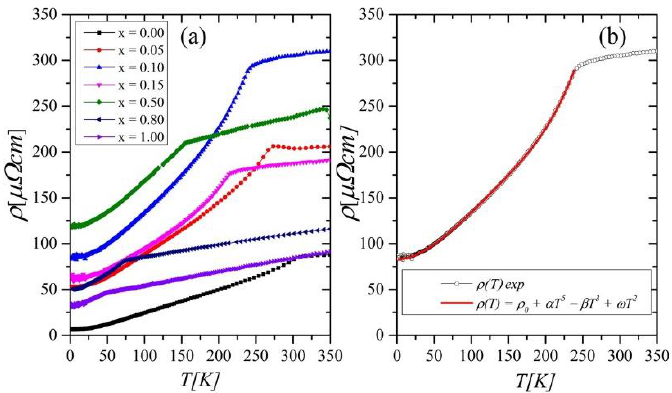
Figure 11. ( a ) Electrical resistivity ρ ( T ) for the Gd 0.4 Tb 0.6 (Co 1 − x Ni x ) 2 compounds, ( b ) the fit of the experimental ρ ( T ) for x = 0.10, according to Formula (7).